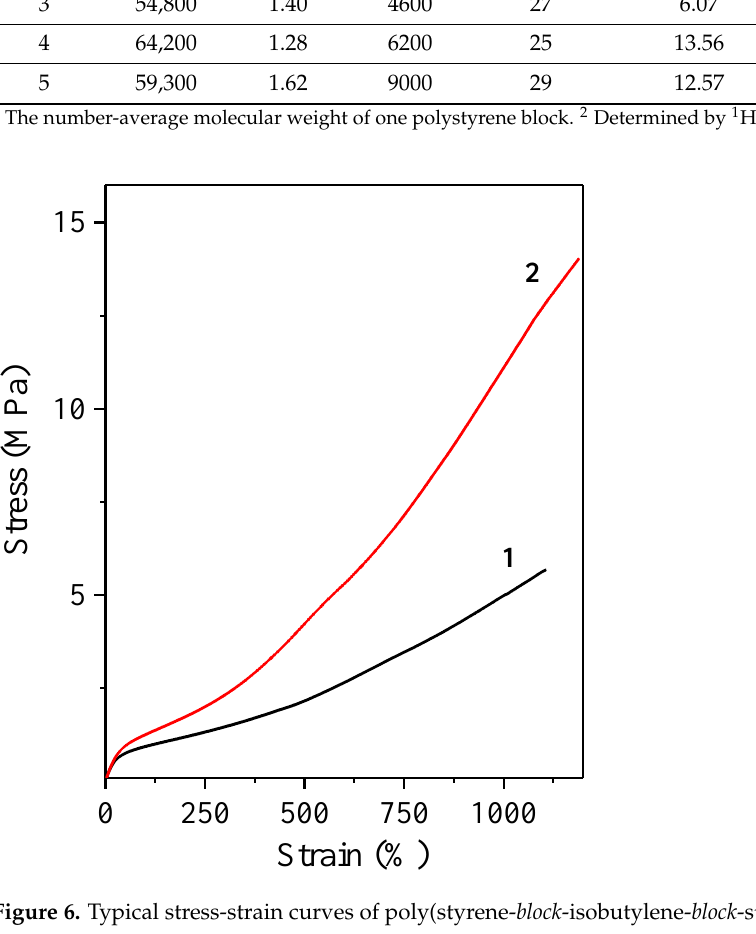
Figure 6. Typical stress-strain curves of poly(styrene- block -isobutylene- block -styrene) synthesized in this work: 1 (run 3, Table 2); 2 (run 4, Table